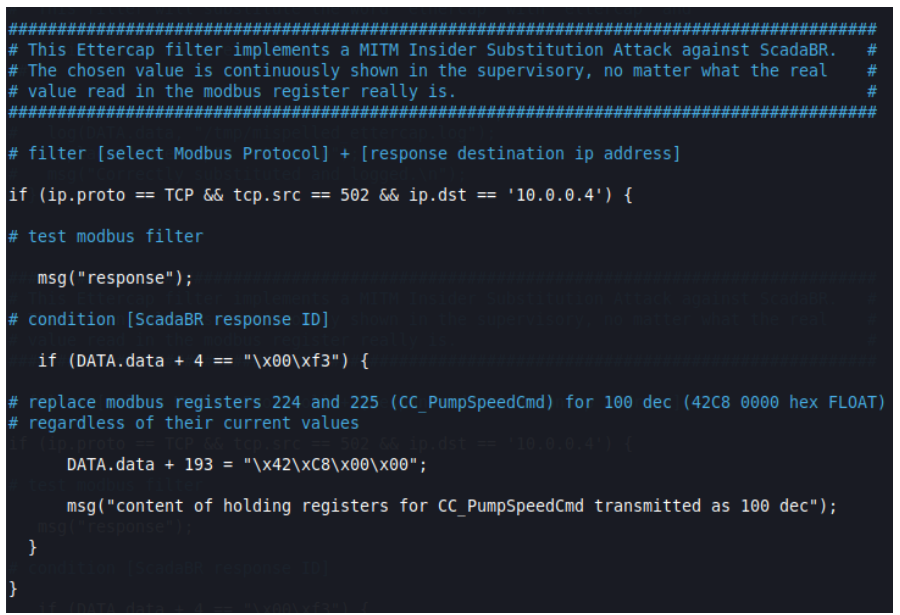
Figure 18. Ettercap MITM changing values filter